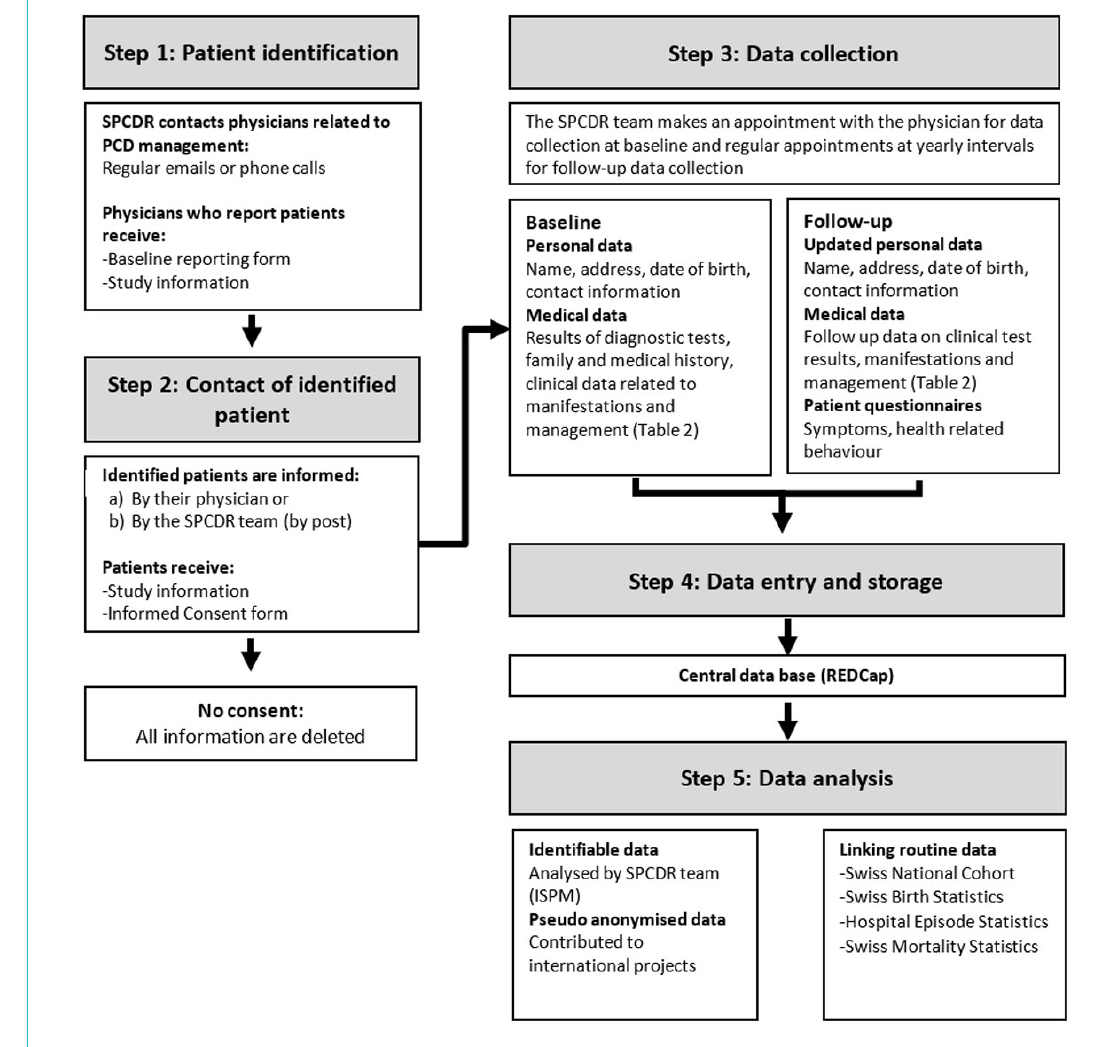
Figure 1: Schematic chart of patient identification and data collection for the Swiss PCD